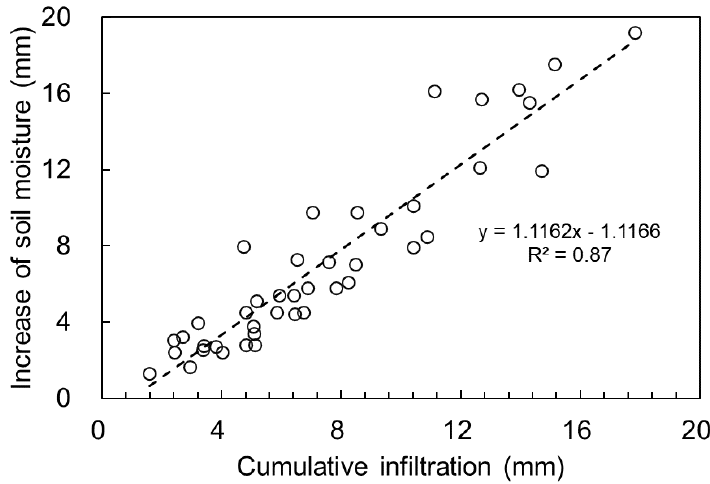
Figure 2. The result of water balance analysis (each circle corresponds to an experimental scenario).